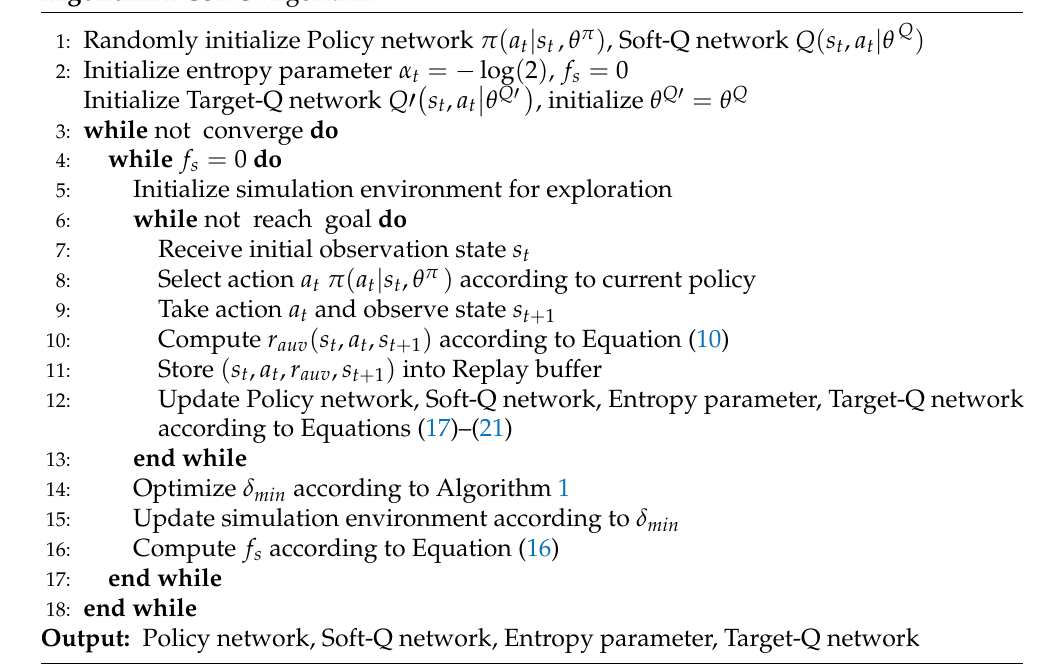
Algorithm 2 GSAC